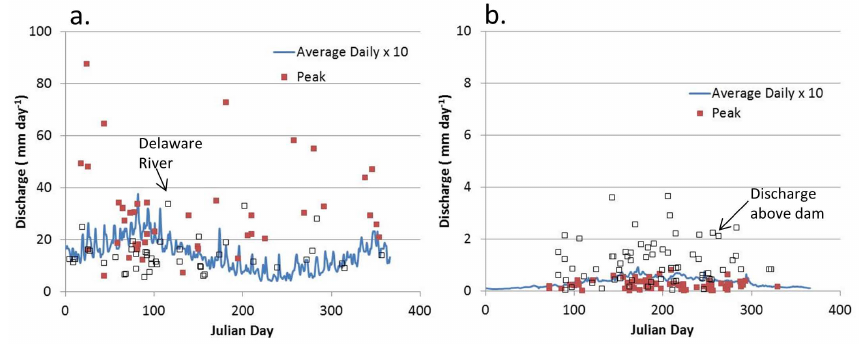
Fig. 3. Average daily discharge and peak annual discharge plotted against Julian Day for Marsh Creek, PA (panel a ) and the Smoky Hill River, KS (panel b ). In (a) , the open symbols show annual peak from the Delaware River at Trenton from 1967–2010. In (b) , the open symbols indicate annual peaks from an upstream gage on the Smoky Hill River not influenced by a